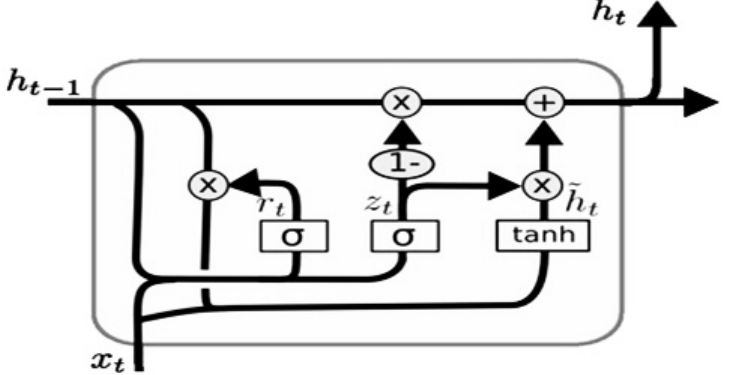
Figure 7. Gated Recurrent Unit (GRU)